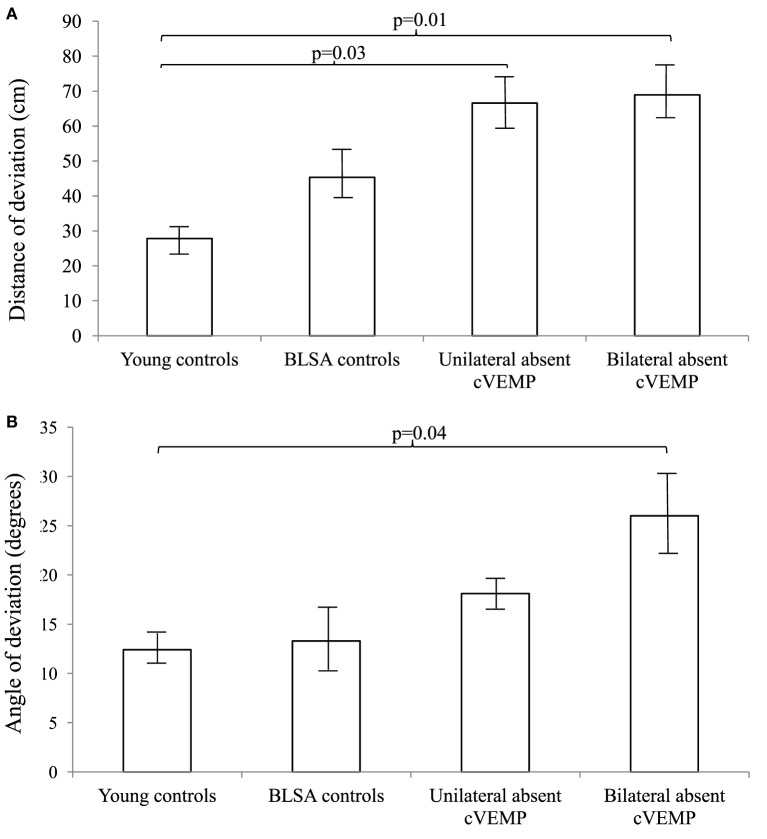
Distance (A) and angles (B) of deviation by cervical vestibular-evoked myogenic potential (cVEMP) response. We included 9 young controls, 15 Baltimore Longitudinal Study of Aging (BLSA) controls, and 24 clinic patients (12 unilateral absent and 12 bilaterally absent cVEMP responses). An analysis of variance demonstrated significant differences in the distance and angles across cVEMP categories (p < 0.01). A pairwise post hoc analysis revealed differences that were indicated by the brackets. Error bars indicate the SEM.